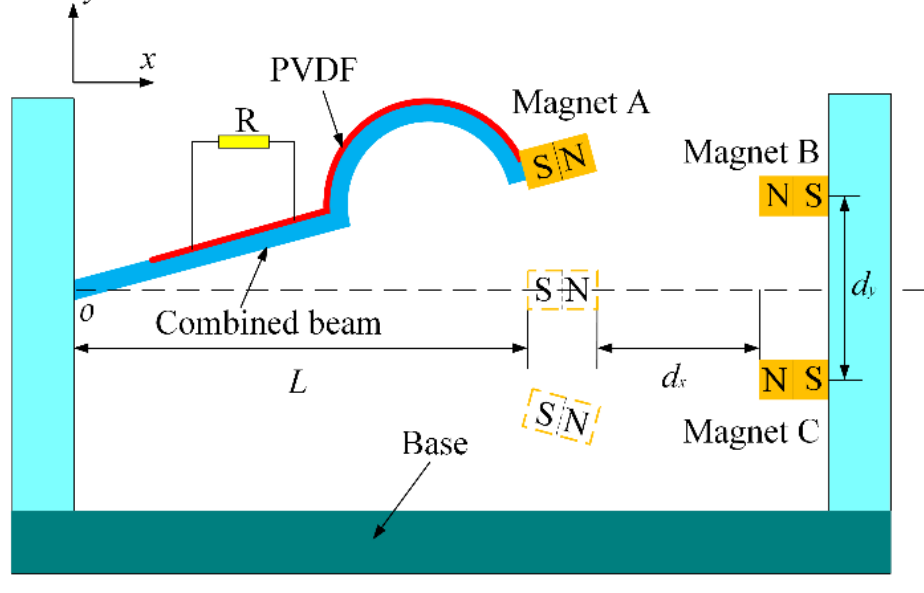
Figure 1. Schematic diagram of the structure of CTPEH.